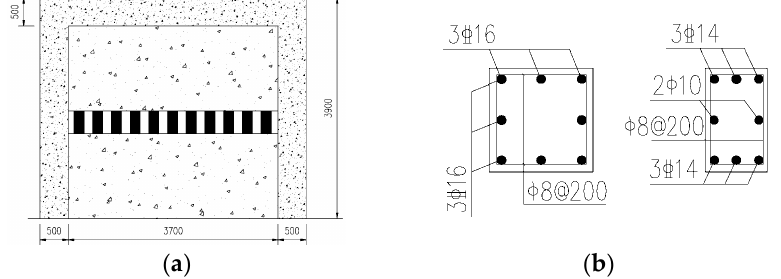
Figure 2. The related design diagrams of GJ-1 (unit: mm). ( a ) Frame structure with CFST damper; ( b ) CFST damper; ( c ) reinforcement drawing of frame beam and column. The relevant design of GJ-2 [12] is shown in Figure 3.